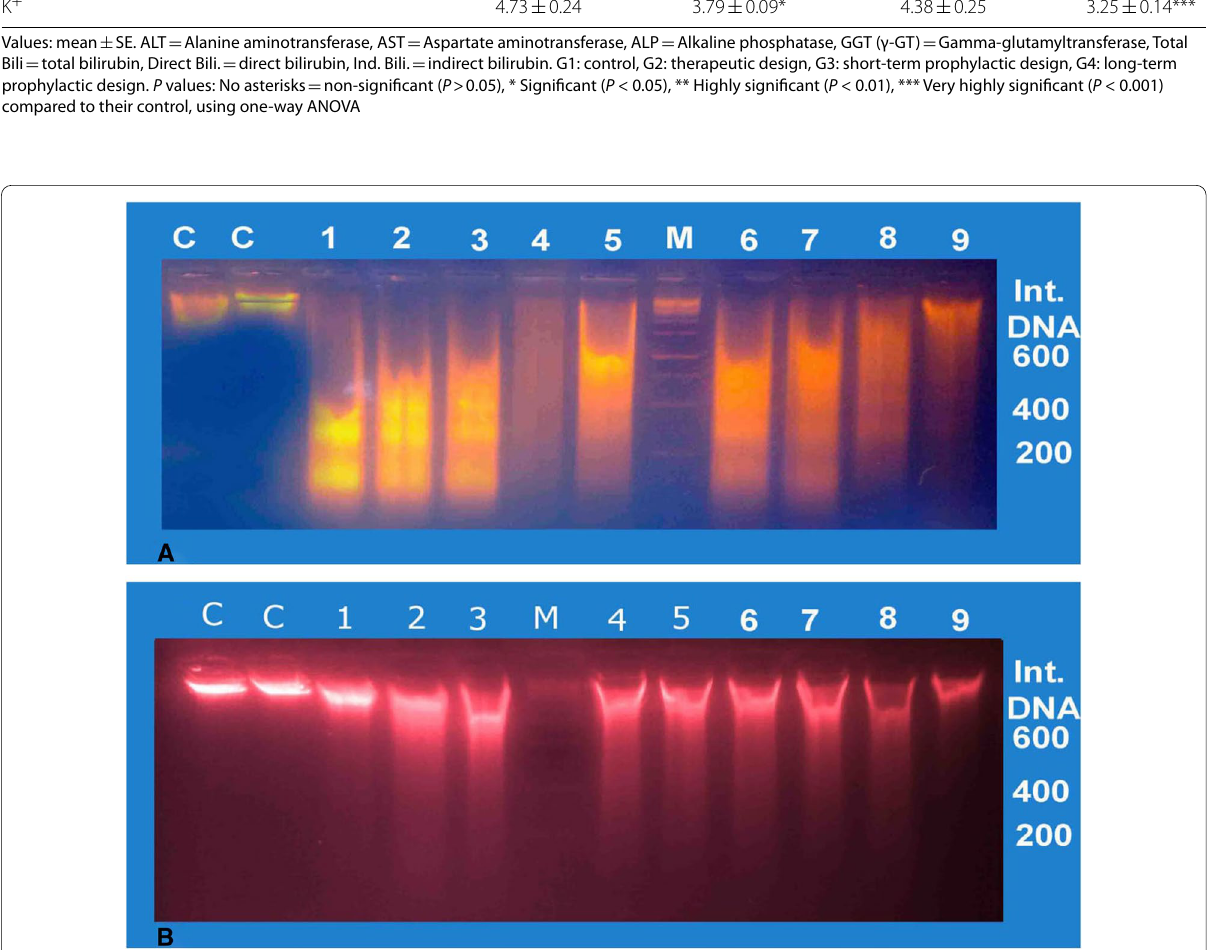
Fig. 7 Gel DNA electrophoresis of the liver ( A ) and kidneys ( B ) rats’ specimens. Lanes C, Lanes 1–3, Lanes 4–6, Lanes 7–9: electrophoretic analyses of G1 , G2 , G3 & G4 ; respectively. Lane M marker (100 bp/DNA ladder). G1: control, G2: therapeutic design, G3: short‑term prophylactic design, G4: = long‑term prophylactic